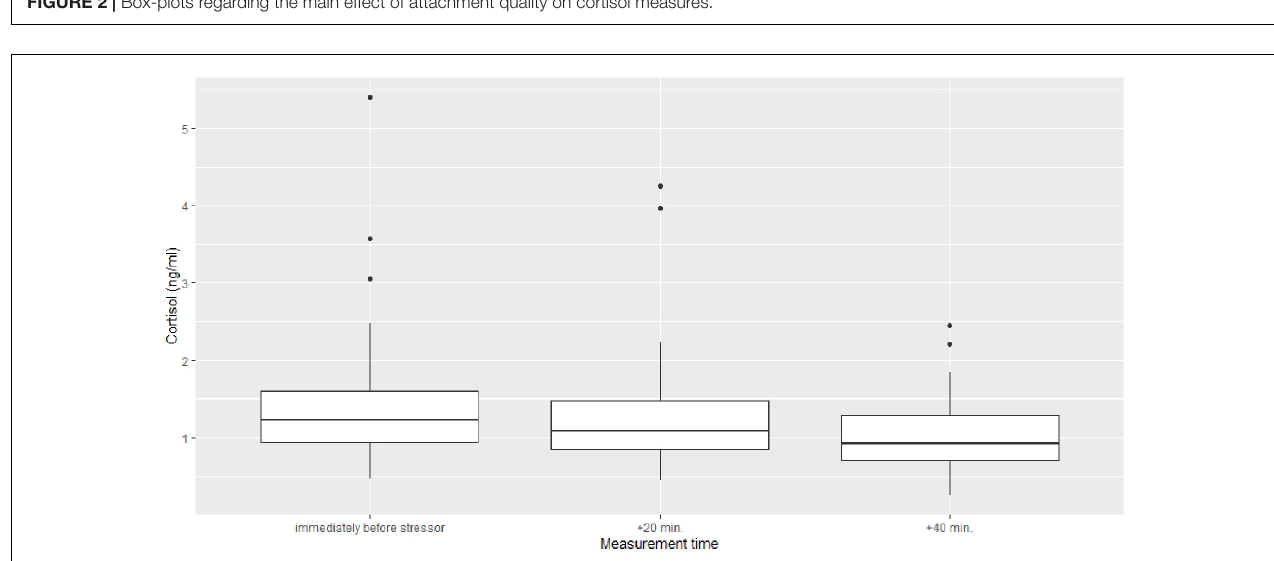
FIGURE 2 | Box-plots regarding the main effect of attachment quality on cortisol measures.